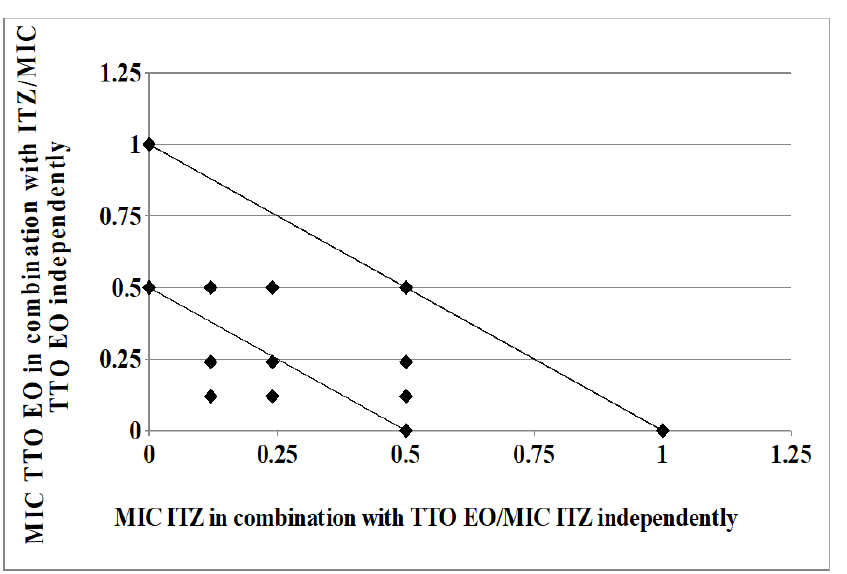
Figure 3. Isobologram of a synergistic interaction between TTO and ITZ against Trichophyton rubrum SL 171/13 strain. ITZ–FIC data are drafted on the x -axis, while TTO–FIC values are drafted on the y -axis.